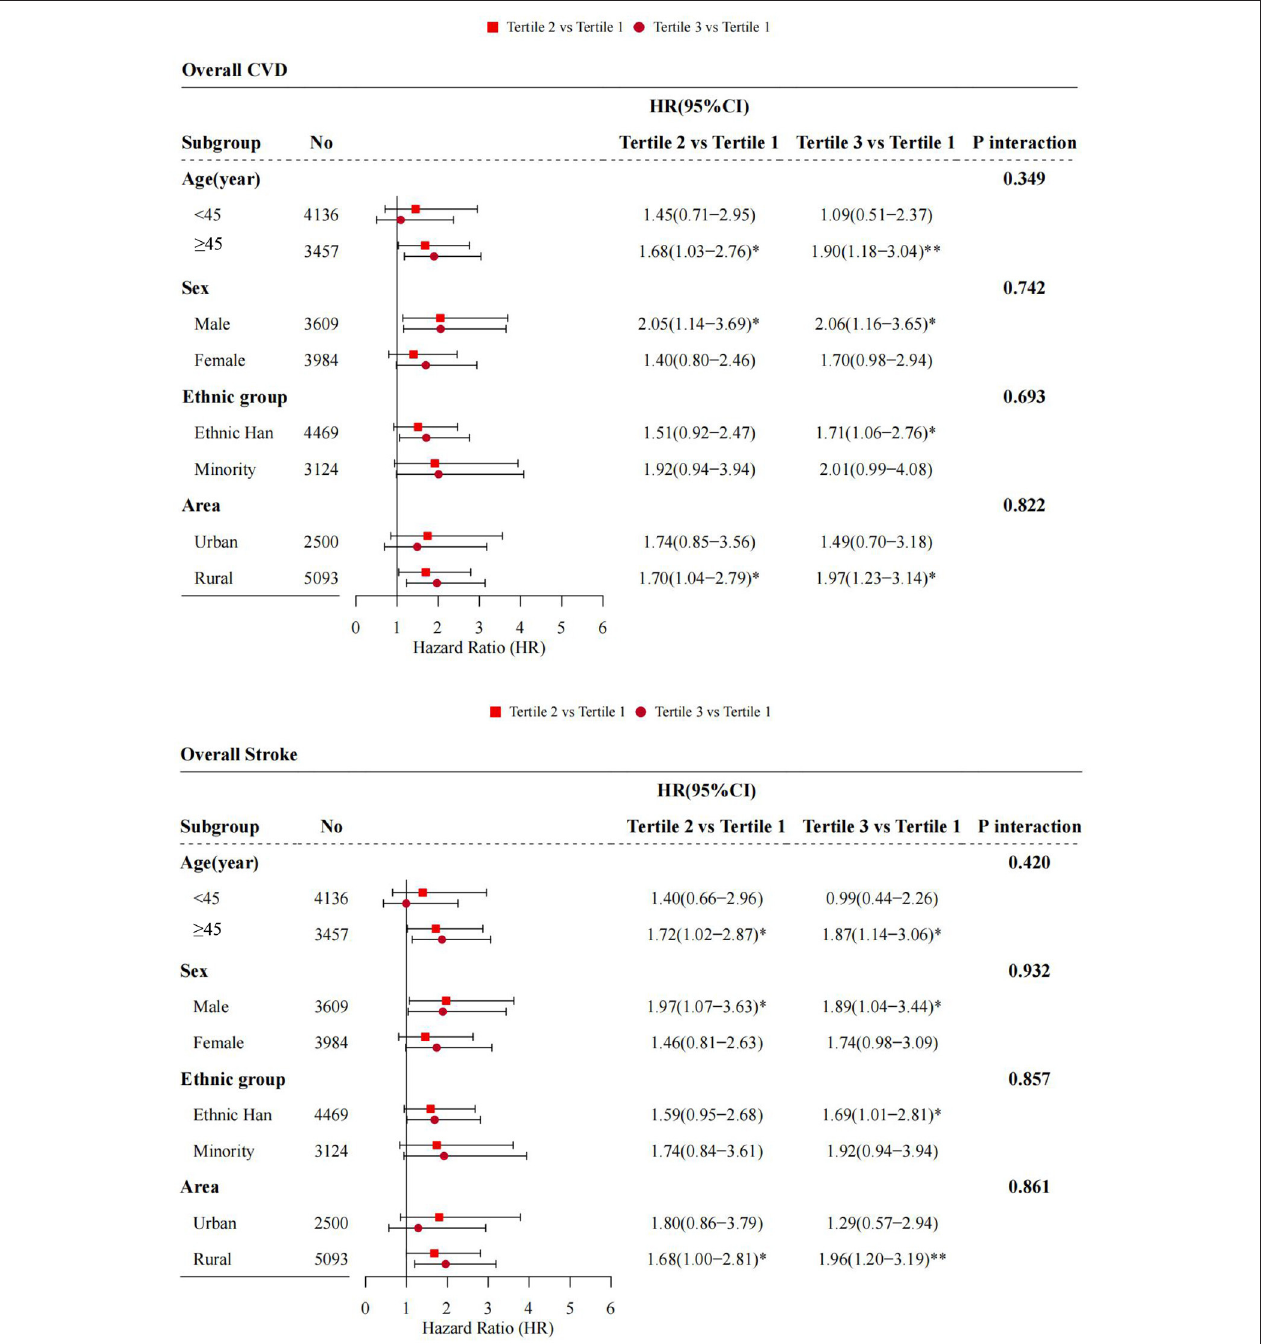
FIGURE 5 | Adjusted hazard ratios (HRs) and 95% confidence intervals (95%CIs) for cardiovascular disease (CVD) associated with baseline 2-h postload glucose (2h-PG) across baseline demographic factors. * P < 0.05; ** P < 0.01.